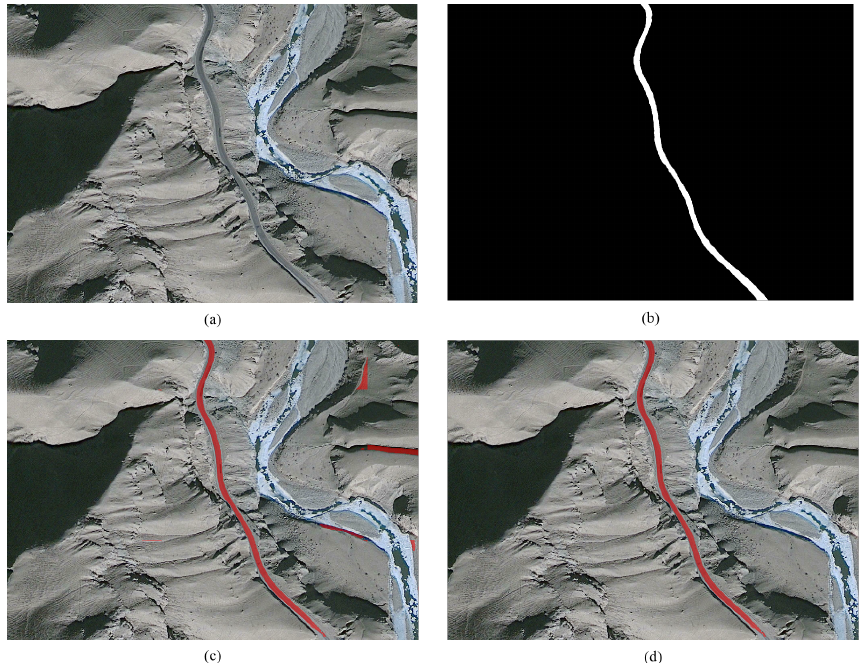
Figure 8. The first image result used for prediction. ( a ) is the original imagery; ( b ) is the manual road label; ( c ) is the prediction roads of Light Roadformer; ( d ) is the prediction after